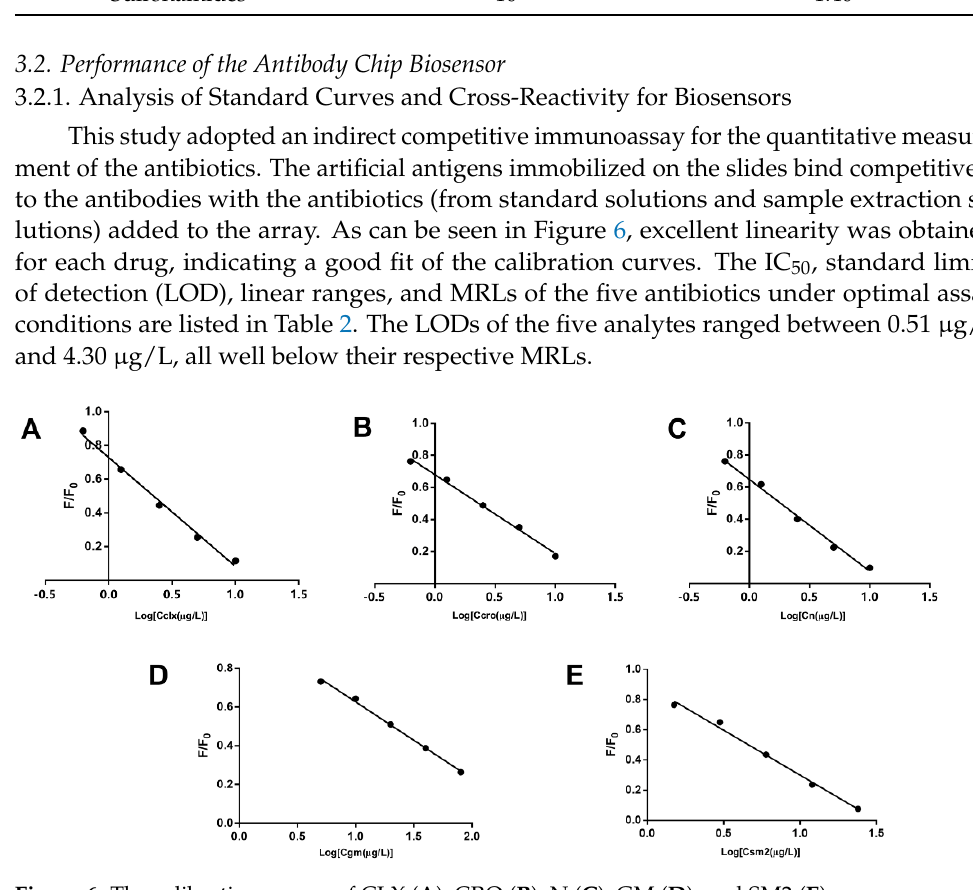
Figure 6. The calibration curves of CLX ( A ), CRO ( B ), N ( C ), GM ( D ), and SM2 ( E ). Table 2. Performance of the five mAbs and MRLs of the corresponding antibiotics.